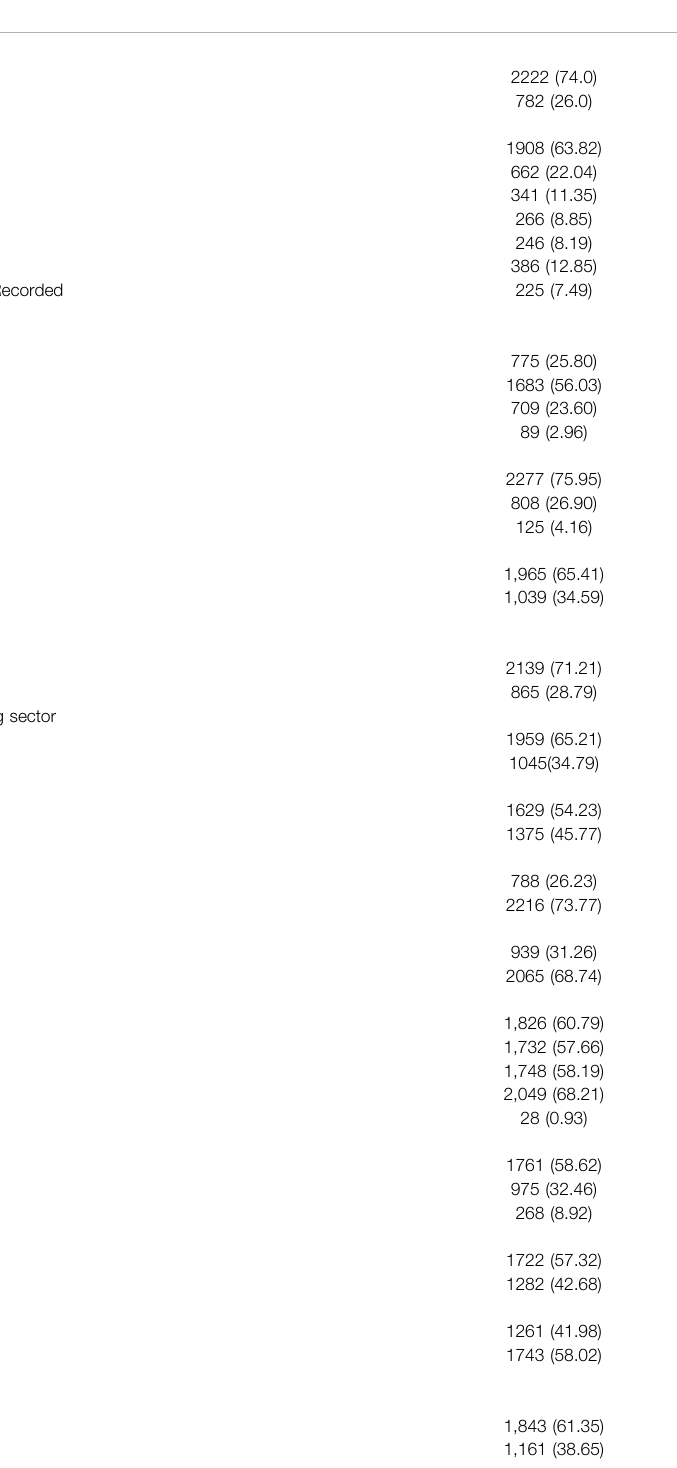
TABLE 2 | Awareness, perception and challenges associated with e-learning among healthcare workers. Awareness about e-learning